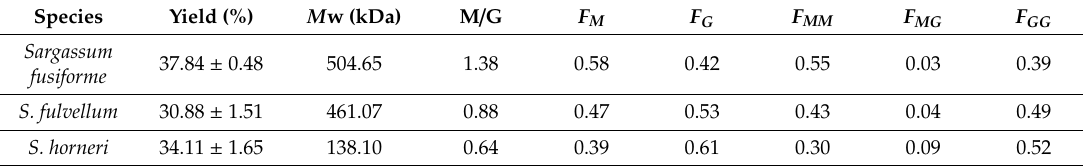
Table 1. Composition of sodium alginate extracted from Sargassum